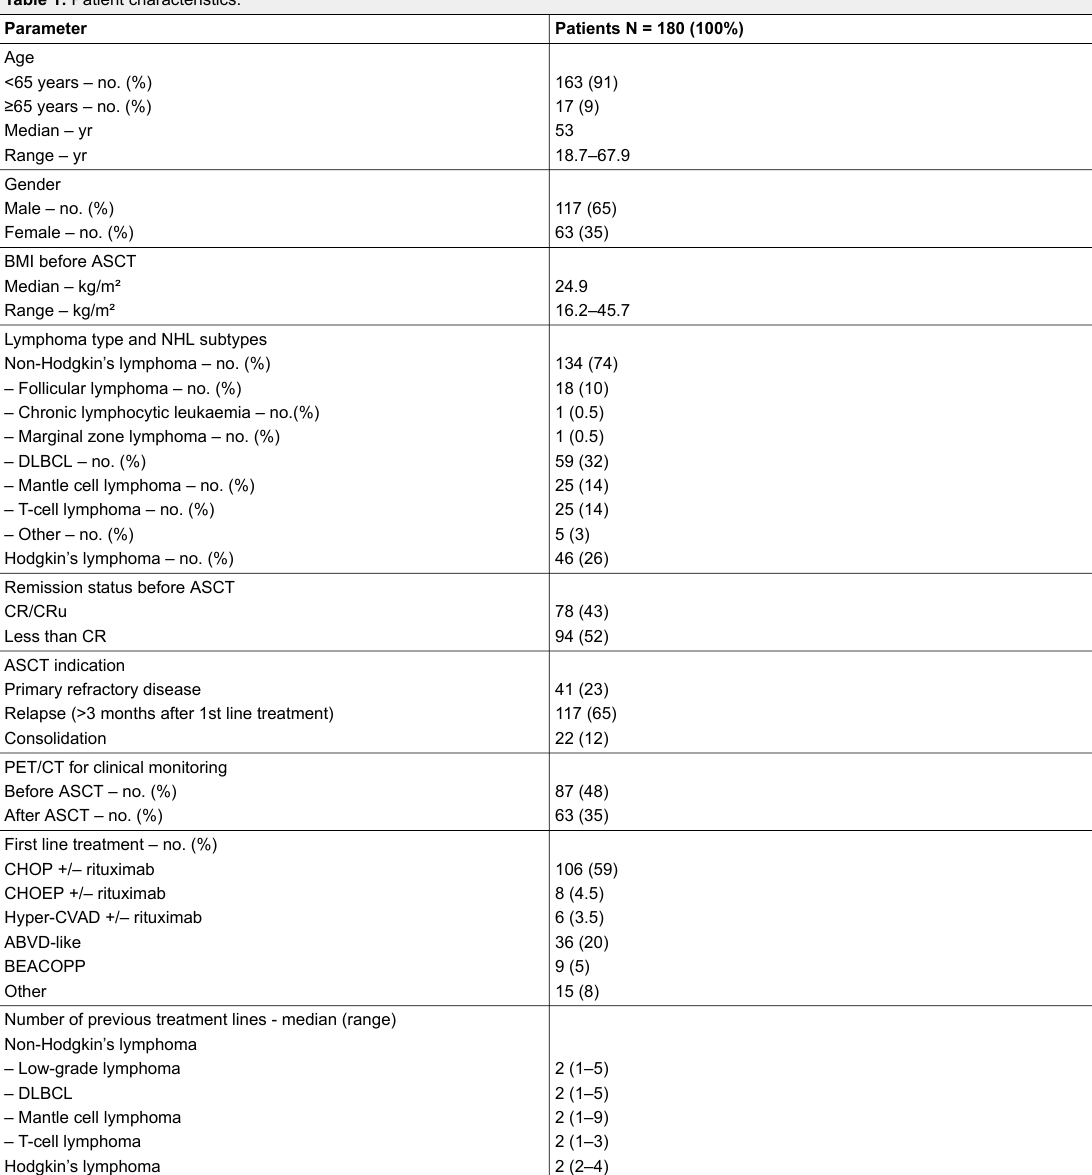
Table 1: Patient